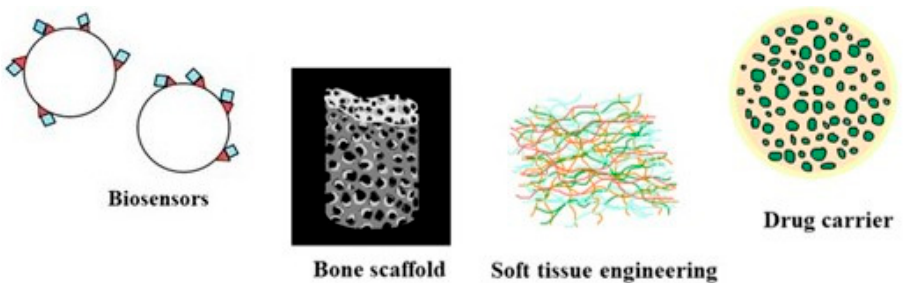
Figure 5. Nanocomposites of PHA as a desirable biomaterial for biosensors, bone scaffold, soft tissue engineering, and drug carrier.